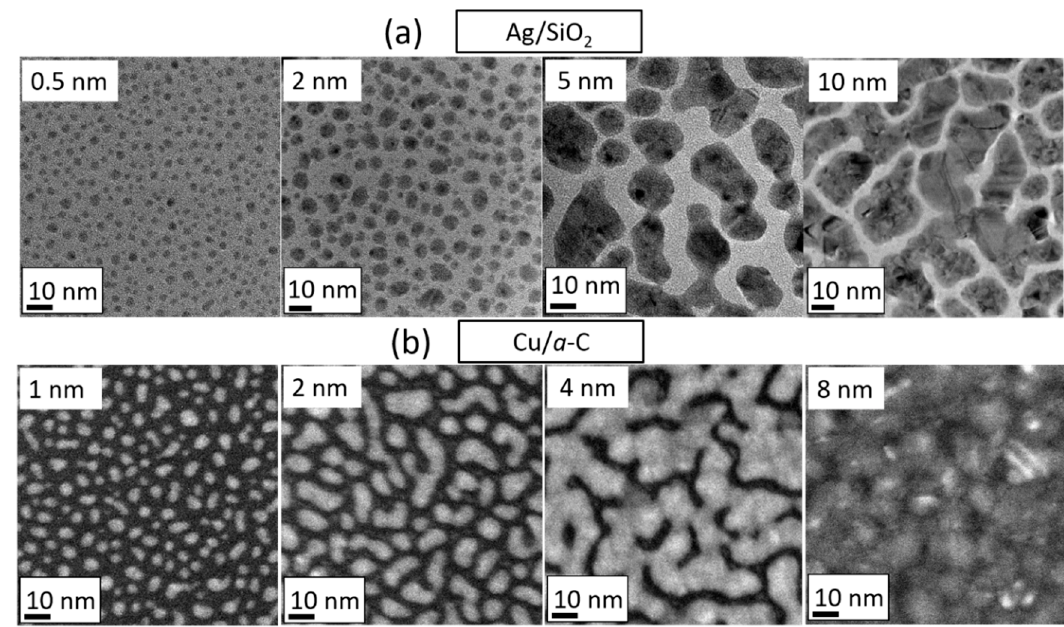
Figure 3. Plan-view TEM micrographs showing the morphological evolution and various formation stages of ( a ) Ag and ( b ) Cu thin films with different thickness deposited on SiO 2 (Ag) and a-C (Cu) by magnetron sputtering at room temperature. Island nucleation and growth at 0.5 nm in ( a ); complete coalescence at 2 nm in ( a ); incomplete coalescence and formation of elongated islands at 5 and 10 nm in ( a ) and 1 and 2 nm in ( b ); hole-filling at 4 nm in ( b ); continuous-layer formation at 8 nm in ( b ). Micrographs in ( a ) correspond to bright-field images (Reprinted with permission from [79]. Copyright ACS 2020), while the images in ( b ) were taken using scanning transmission electron microscopy in high-angle annular dark field (STEM-HAADF) mode (Reprinted with permission from [78]).